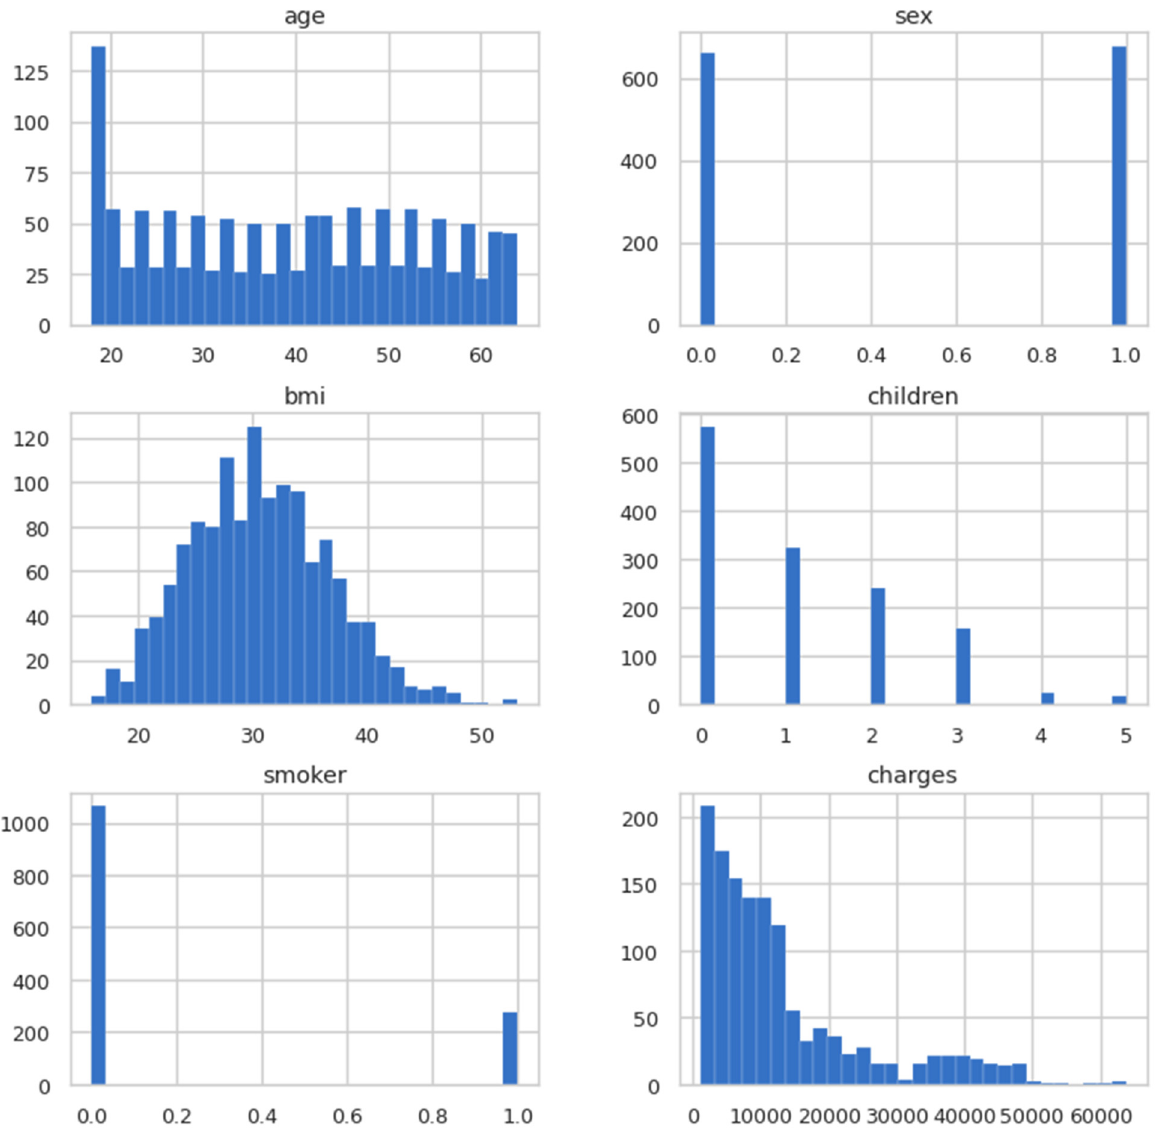
Figure 3. Histogram plots for columns.